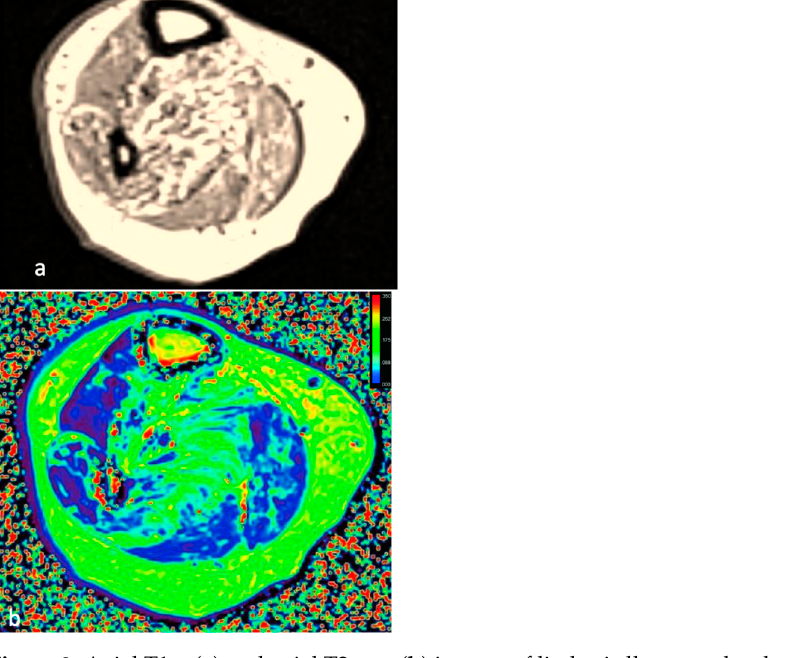
Figure 3. Axial T1w ( a ) and axial T2map ( b ) images of limb-girdle muscular dystrophy 2I patients show a partial fatty replacement of thigh muscles. The mean T2map value of muscles is 87 ms.